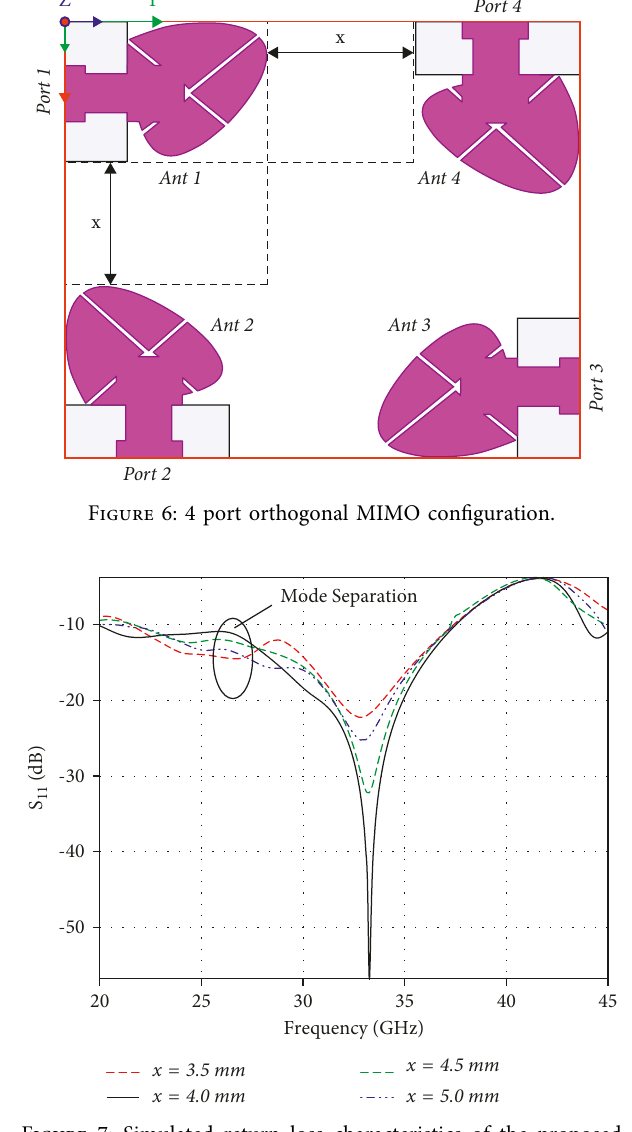
, and L vs. frequency. ′